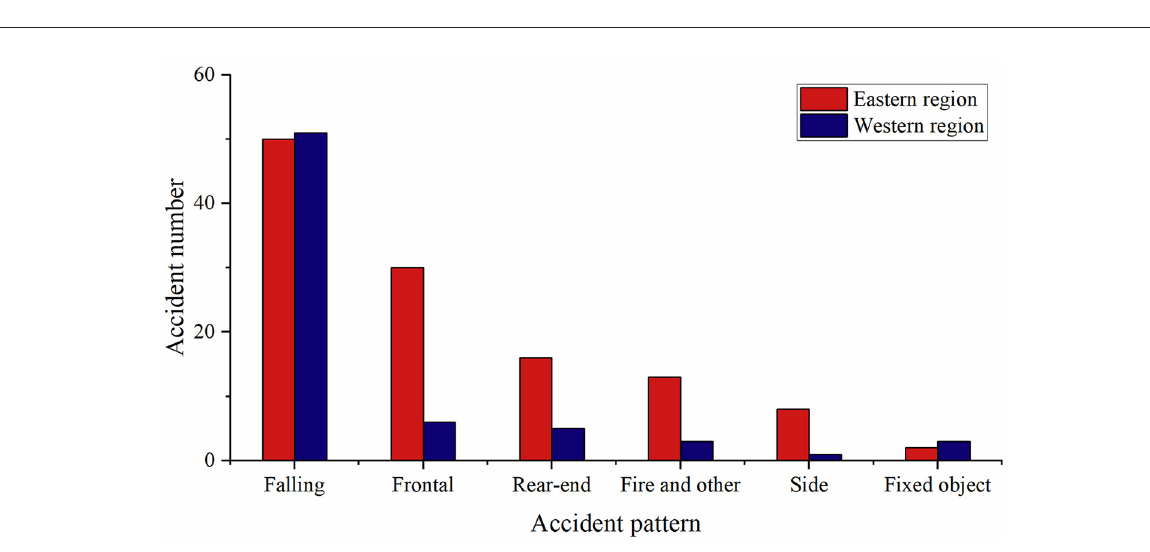
FIGURE6 Extremely serious traffic accident patterns in the eastern and western